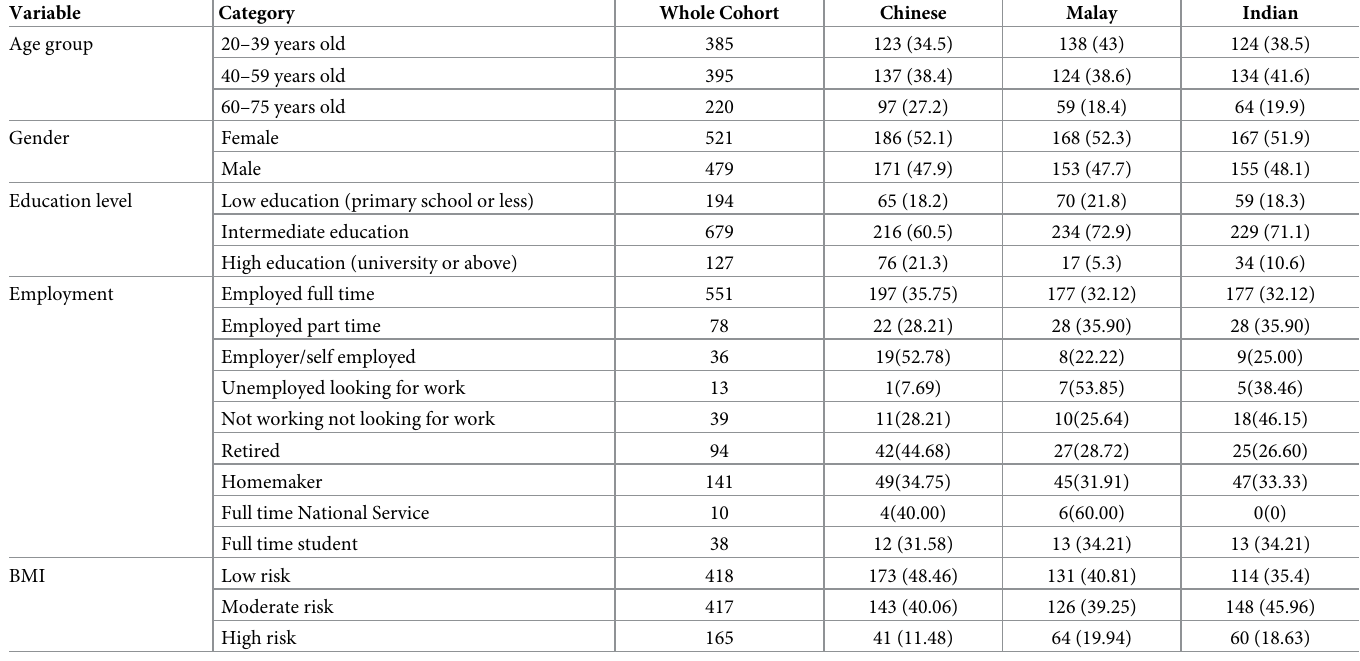
Table 1. Demographics of survey respondents (n =